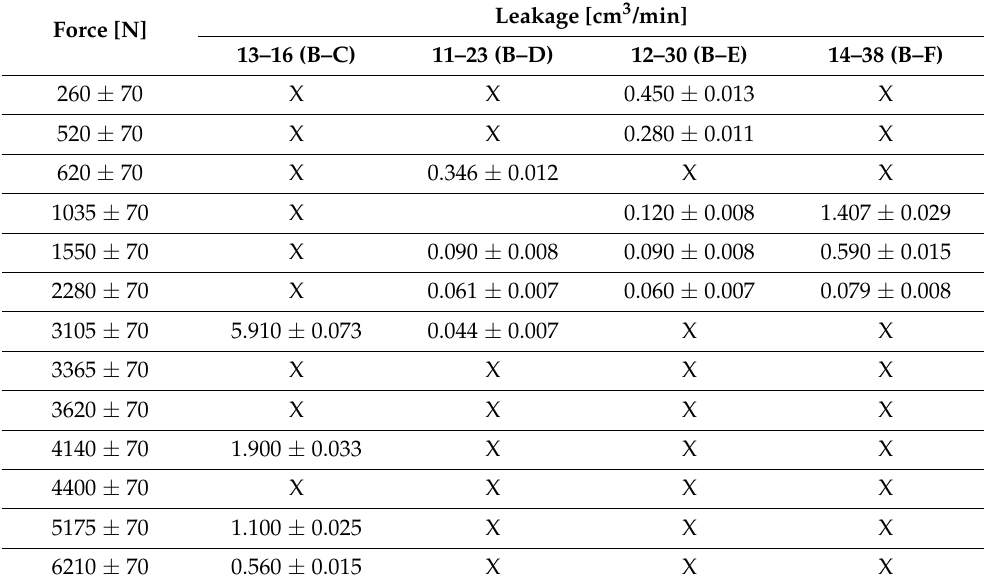
Table 9. Forces and leakage for a pair of samples with surface topography parameters from code groups B, C, D, E, and